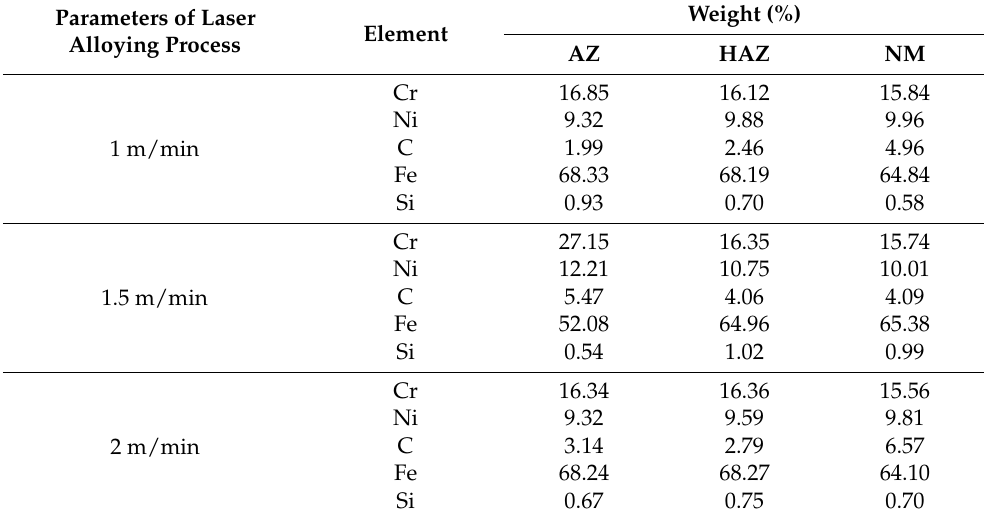
EDX–analysis after laser alloying (AZ—alloying zone, HAZ—heat-affected zone, NM—native material) for sample